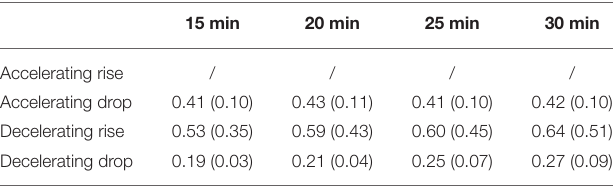
TABLE 4 | The risk of AEs compared with the accelerating-rise